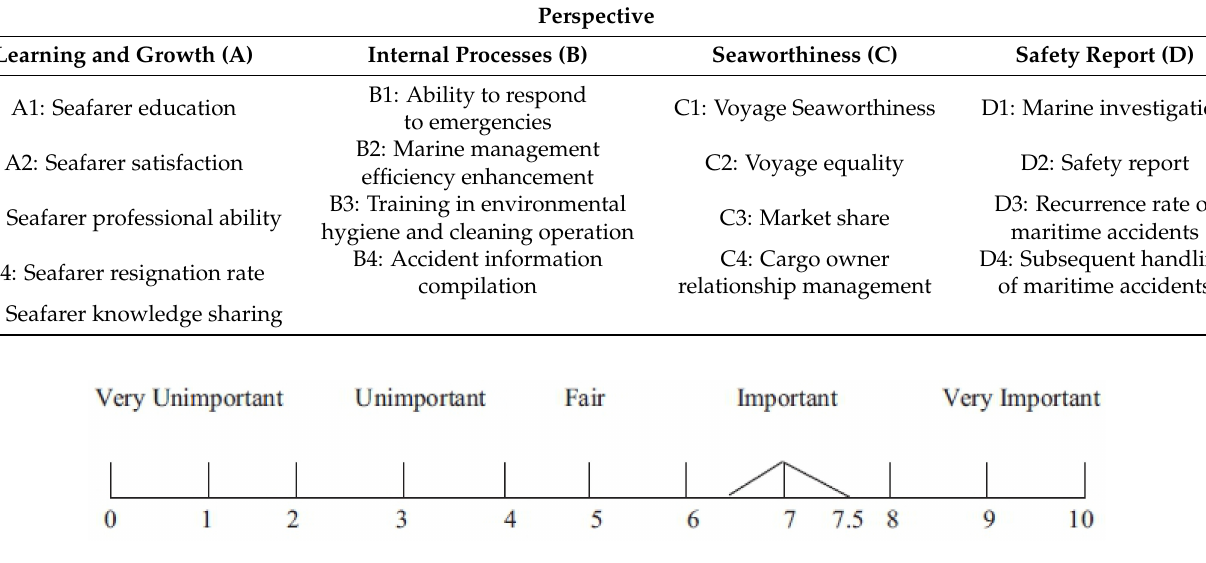
Figure 1. Rank of importance